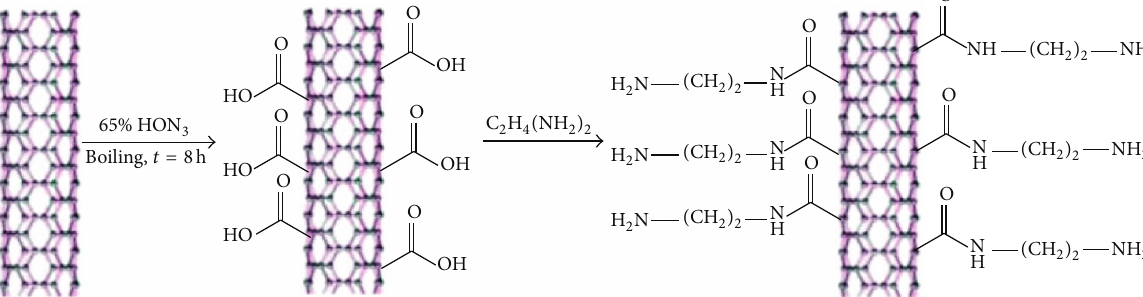
Scheme 5: Amine modification of CNT.